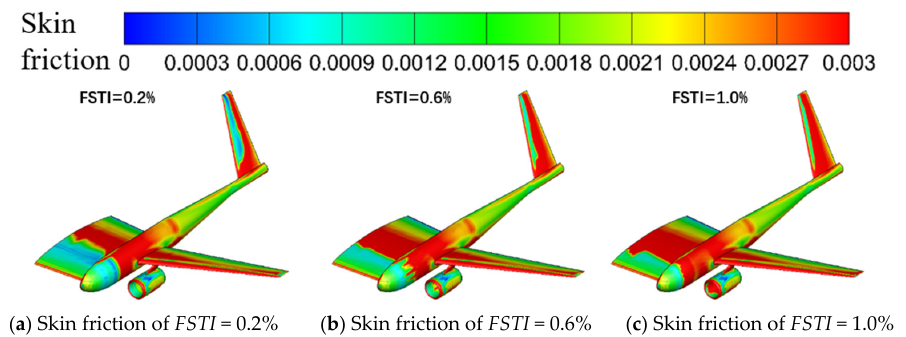
Figure 10. Skin friction coefficient contour of the whole aircraft with different free stream turbulence intensity.